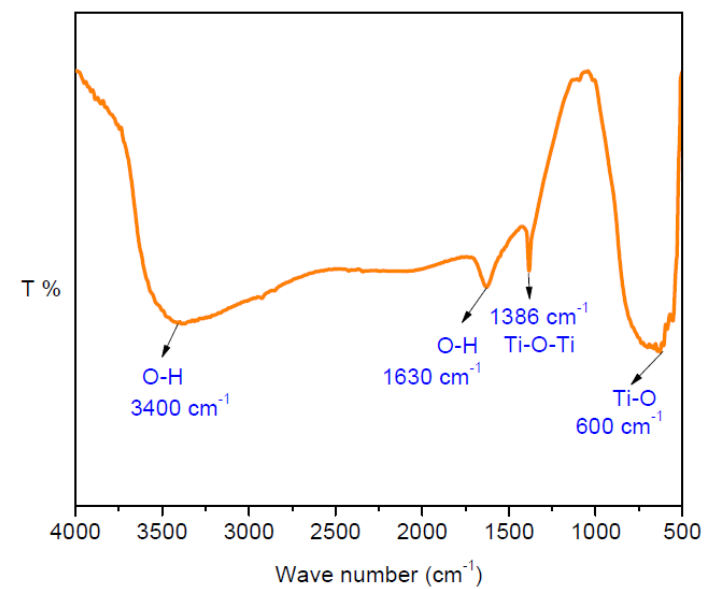
Figure 2. FTIR spectrum of TiO 2